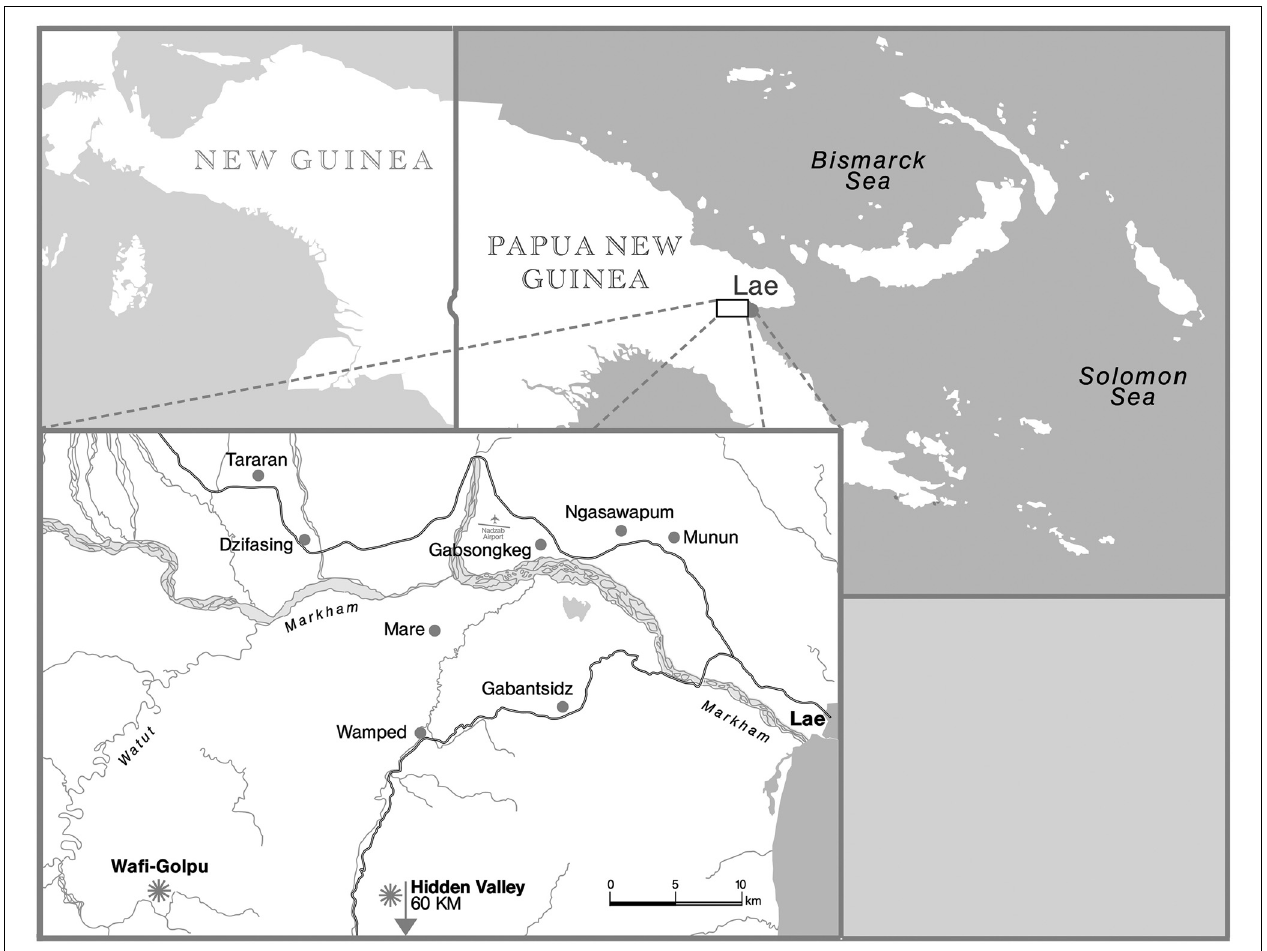
FIGURE 1 | Map of PNG andWampar villages (map H.